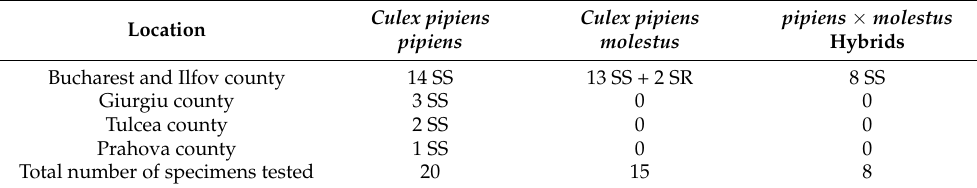
Table 3. Distribution of acetylcholinesterase 1 (AChE1) G119S substitution in the mosquito samples analysed.